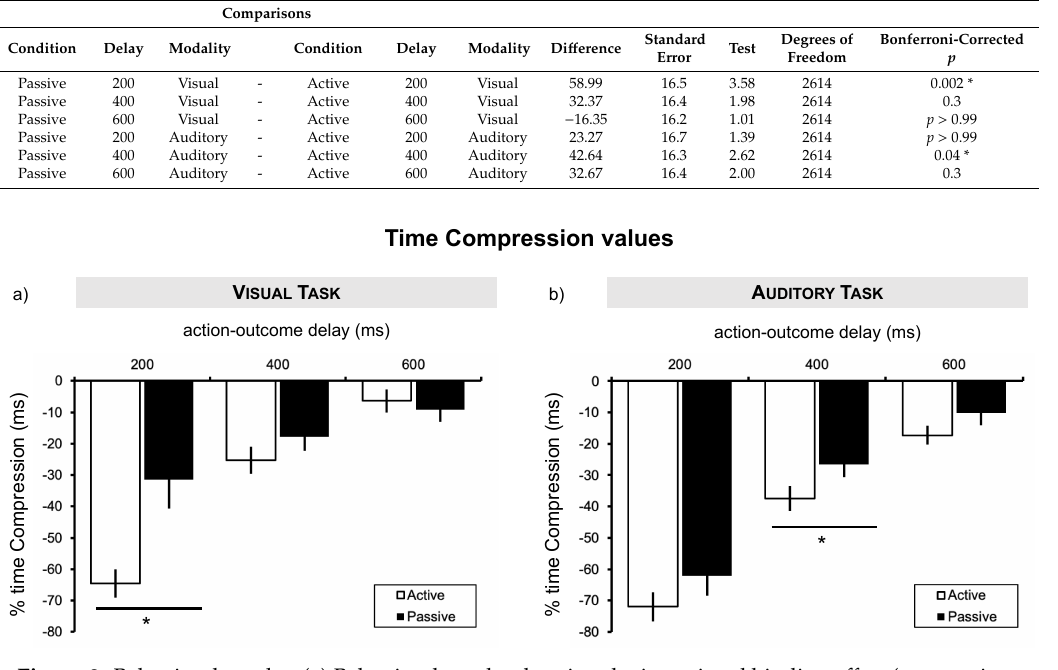
Figure 2. Behavioral results. ( a ) Behavioral results showing the intentional binding effect (greater time compression in the active than passive conditions) at 200ms action-outcome delay for the visual task. ( b ) Behavioral results showing the intentional binding effect (greater time compression in the active than passive conditions) at 400ms action-outcome delay for the auditory task. Error bars = standard error; asterisks indicate significant results at p < 0.05 Bonferroni corrected.